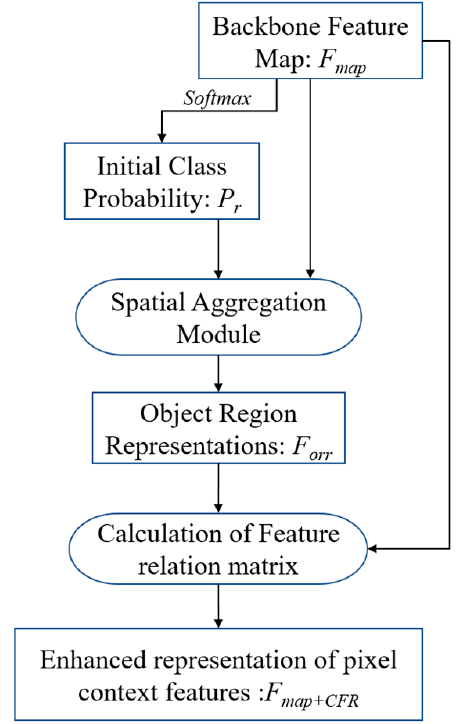
Figure 5. The structure of the CFR module.